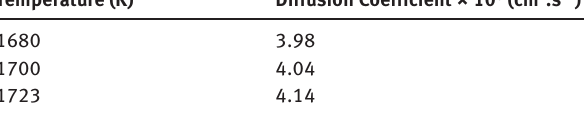
Table II: Diffusion coefficients of sulfur through 51.5 mass% CaO